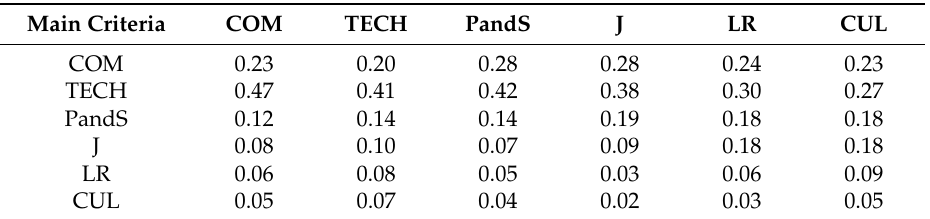
Table 4. Normalized matrix for main